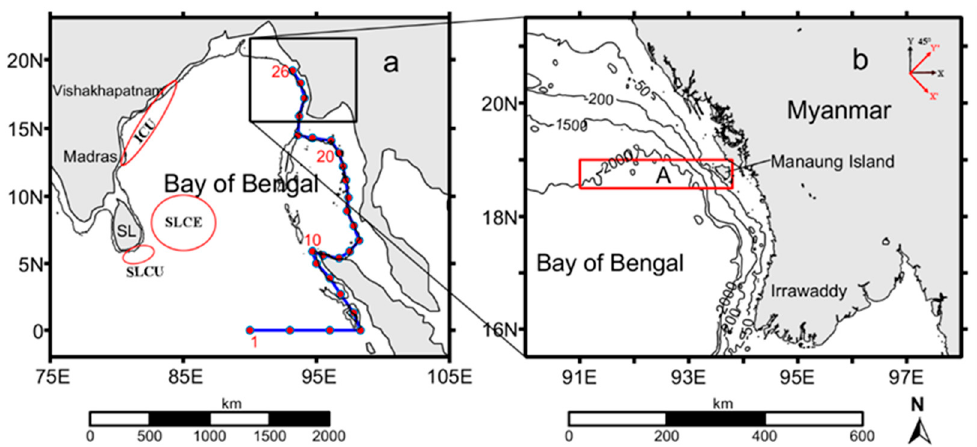
Figure 1. ( a ) Geographical location of the Bay of Bengal, and ( b ) topography of the northwestern coasts of Myanmar. The blue line in Figure 1a indicates the propagation path of the equatorial Kelvin wave and coastal Kelvin wave. The red dots in the blue line denote the selected stations of sea level anomaly (SLA) to track the propagation of Kevin wave along the equator and eastern boundary of the Bay. In Figure 1a, the India coastal upwelling, Sri Lanka coastal upwelling, Sri Lanka Cold Eddy and Sri Lanka are denoted by ICU, SLCU, SLCE and SL, respectively. In Figure 1b, the red box represents the study region A (91.0–93.5°E, 18.5–19.0°N), and the black contours are the isobaths of 50, 200, 1500 and 2000 m.